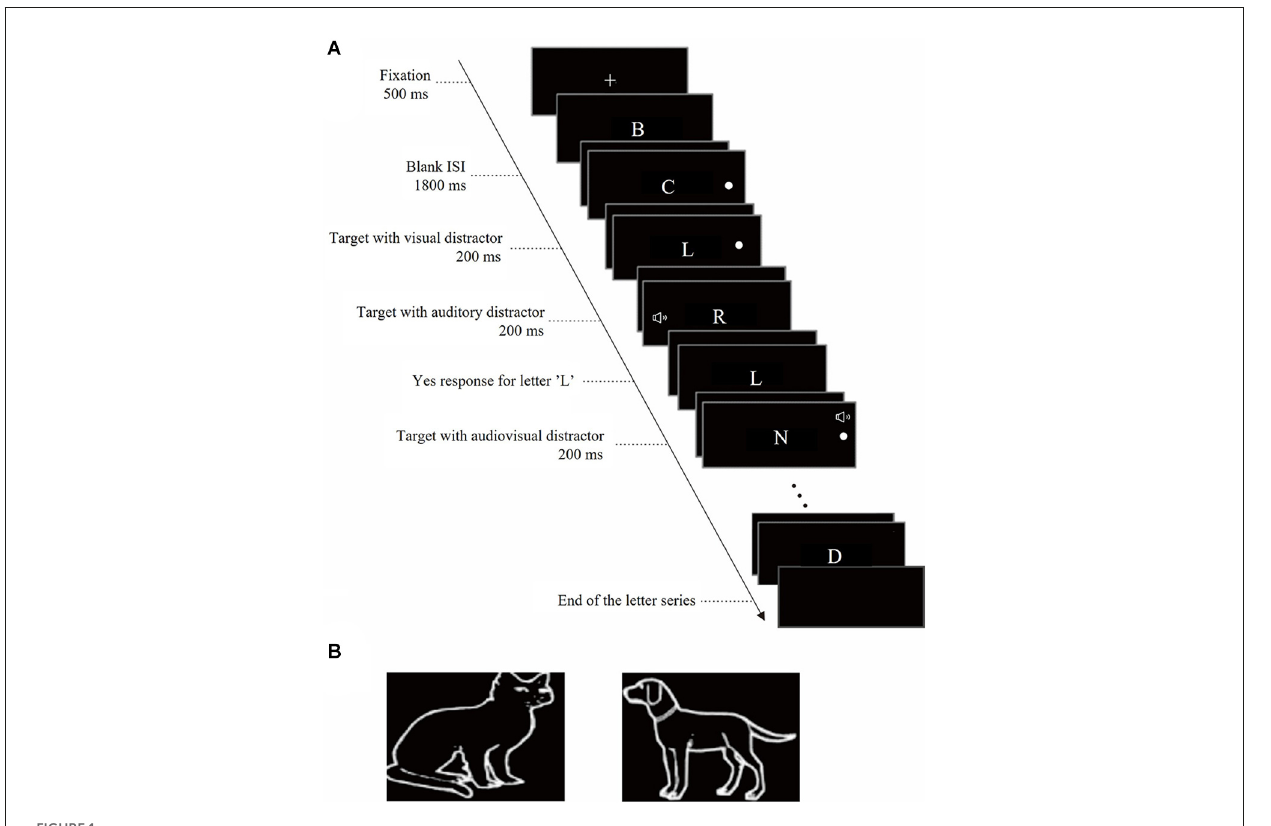
FIGURE1 (A) Trial scheme in Experiment 1 and Experiment 2 (2-back task in Experiment 1 as an example). (B) Stimuli used in Experiment 3.